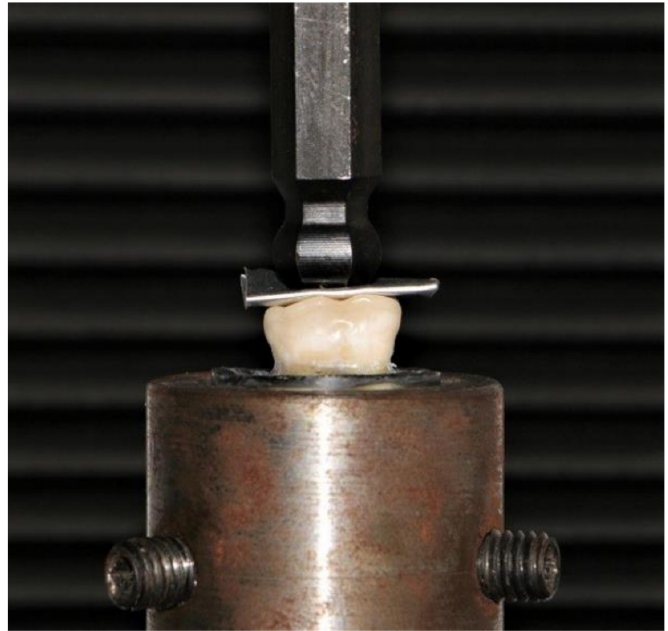
Figure 3. The specimen fixed in the lower compartment of the universal testing machine with the tin foil positioned between the specimen and the metal rod during the fracture